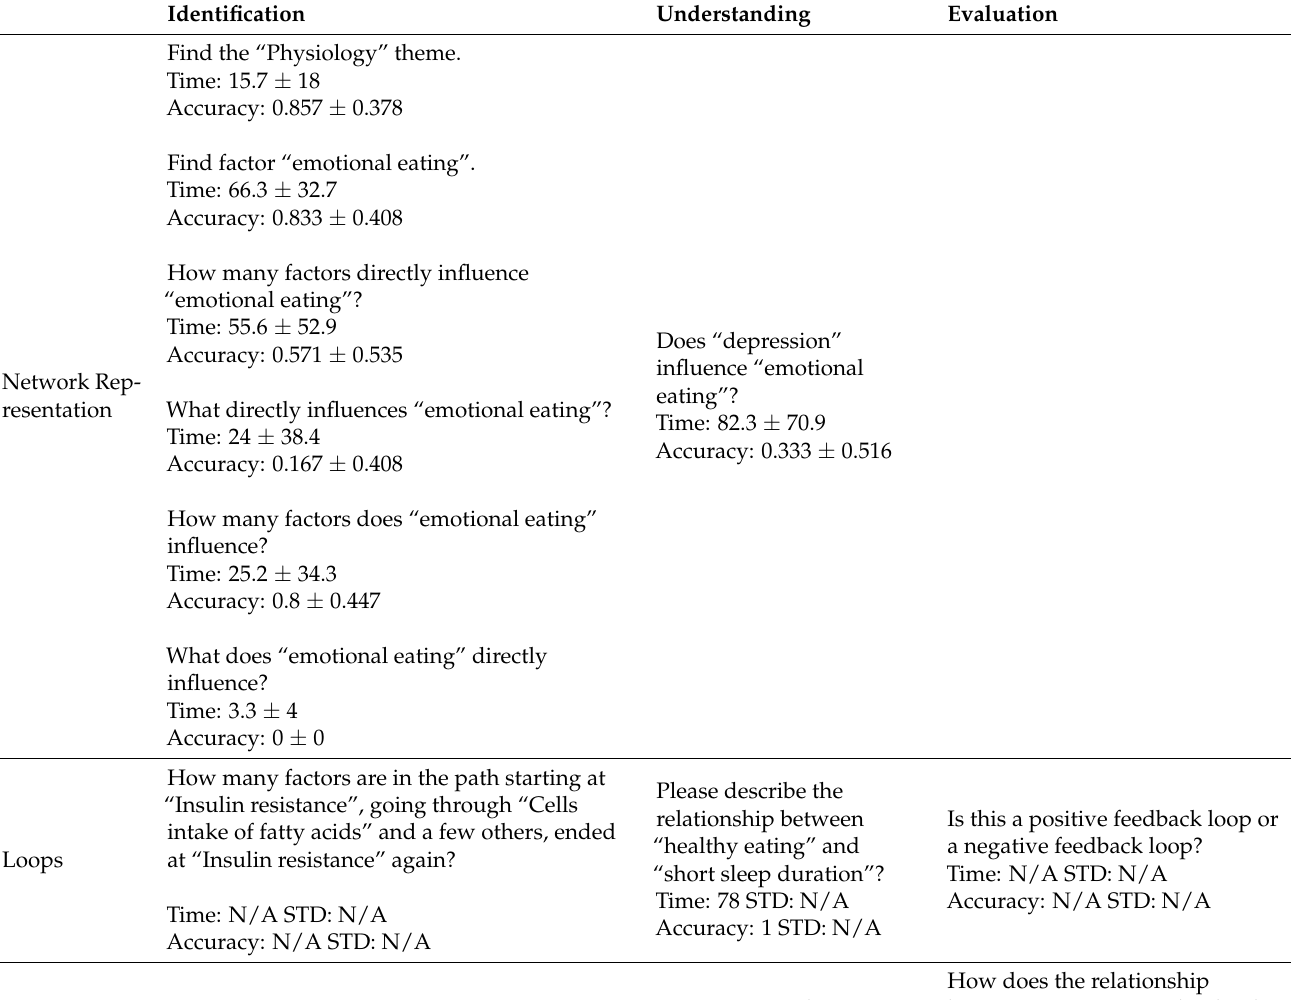
Table A2. Time required to complete each task, and accuracy of answers (when a correct answer